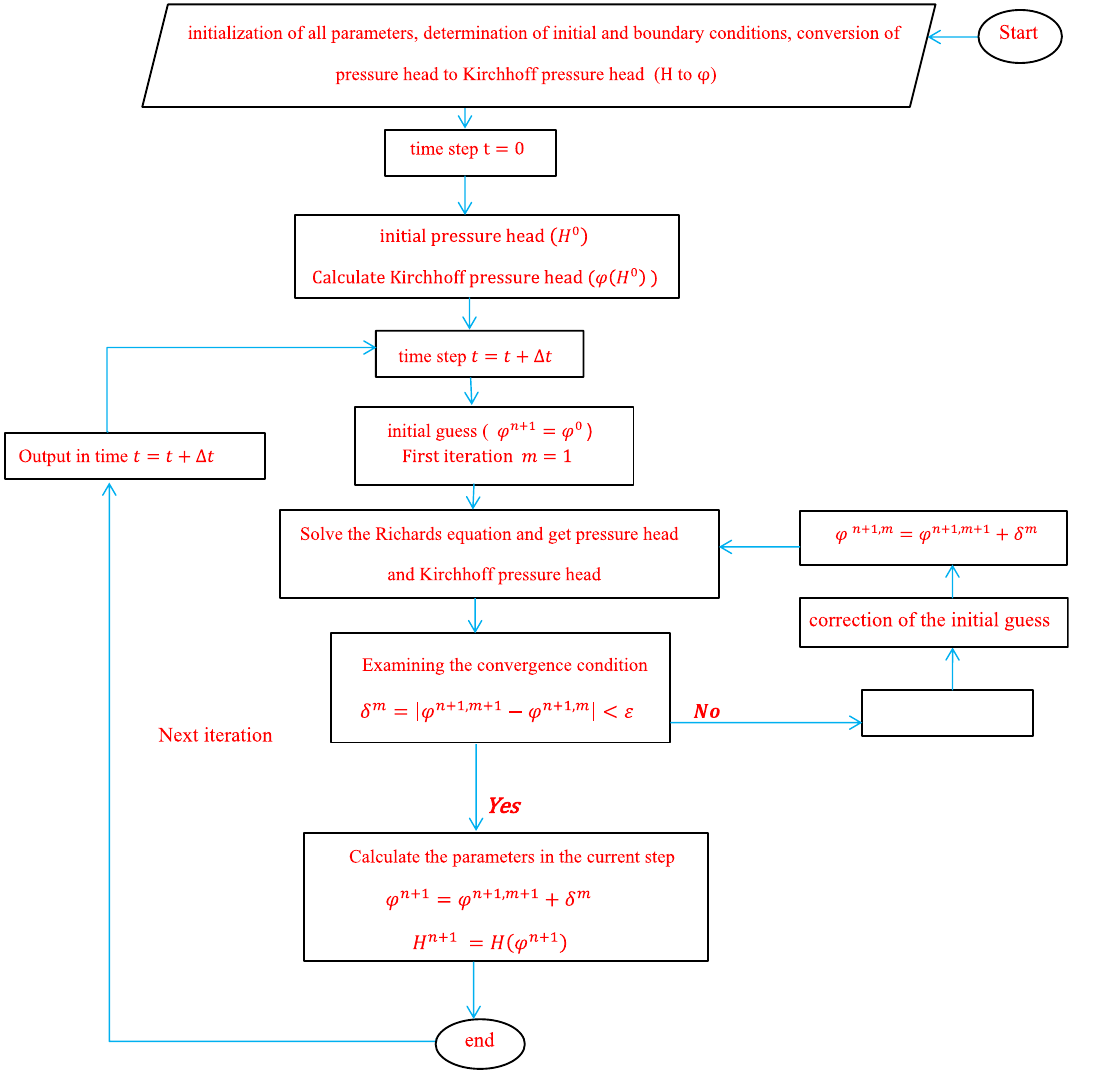
Fig. 1 Richards equation modeling algorithm using local meshless Petrov–Galerkin